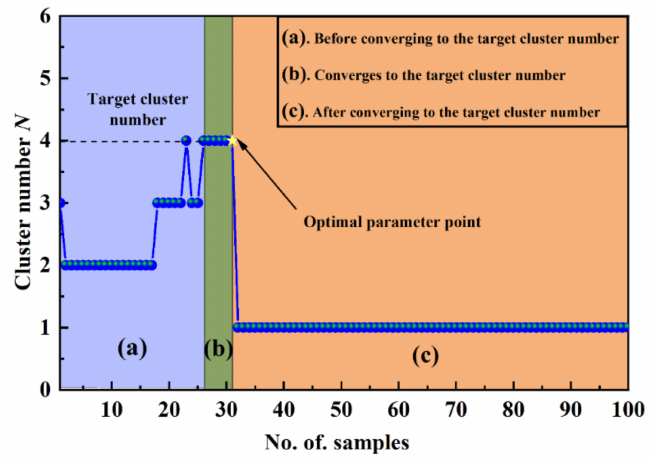
Figure 8. The relationship between the number of clusters and the value of the